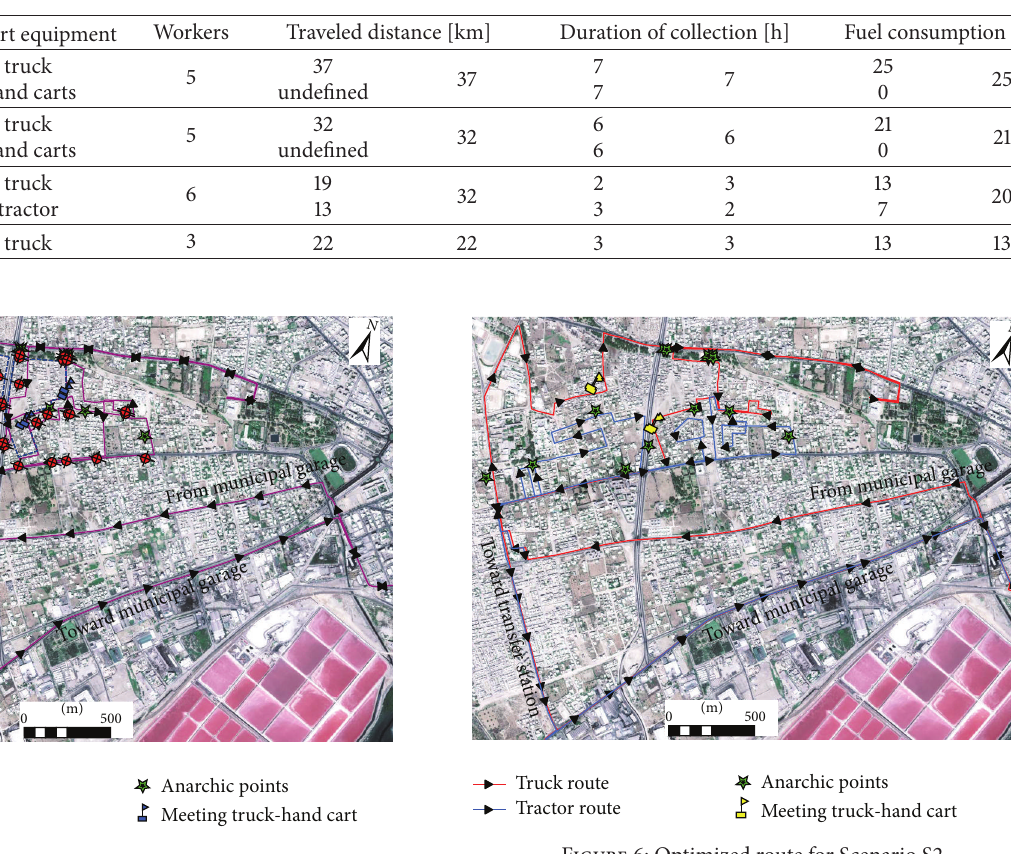
Table 1: Results for analyzed scenarios.